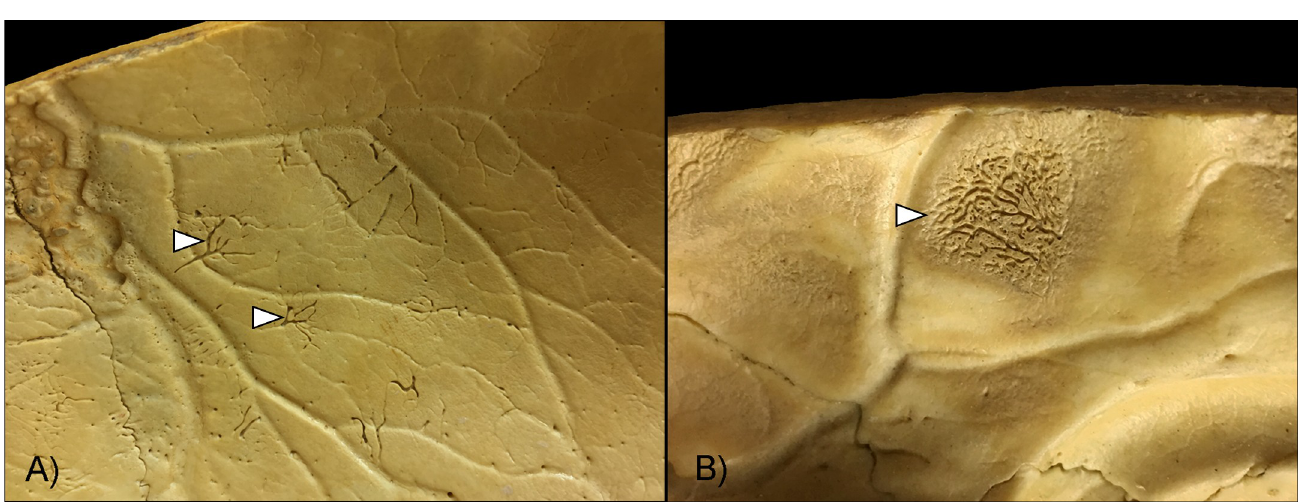
Fig 1. Close-up of ABVIs and PAs (white arrows) on the inner surface of the skull. A) Short, branching ABVIs on the left parietal bone (Terry No. 329, 18-year- old, male, died of pulmonary TB) and B) ABVIs accompanied by PAs on the right parietal bone (Terry No. 254, 21-year-old, male, died of pulmonary TB).